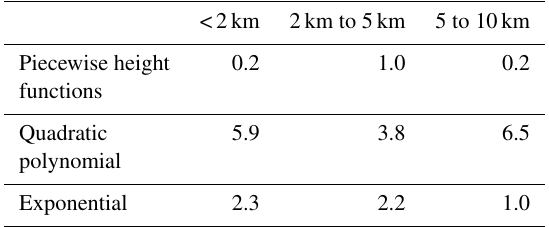
Table 1. Fitting RMSE of piecewise height functions, single quadratic polynomial function, and single exponential function (unit: mm). <2km 2km to 5km 5 to 10km